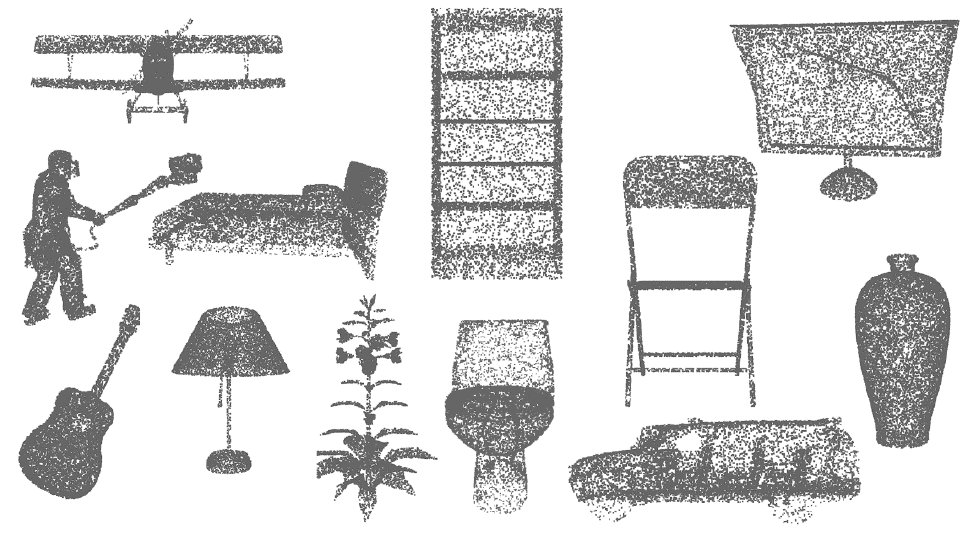
Figure 7. ModelNet40 dataset.